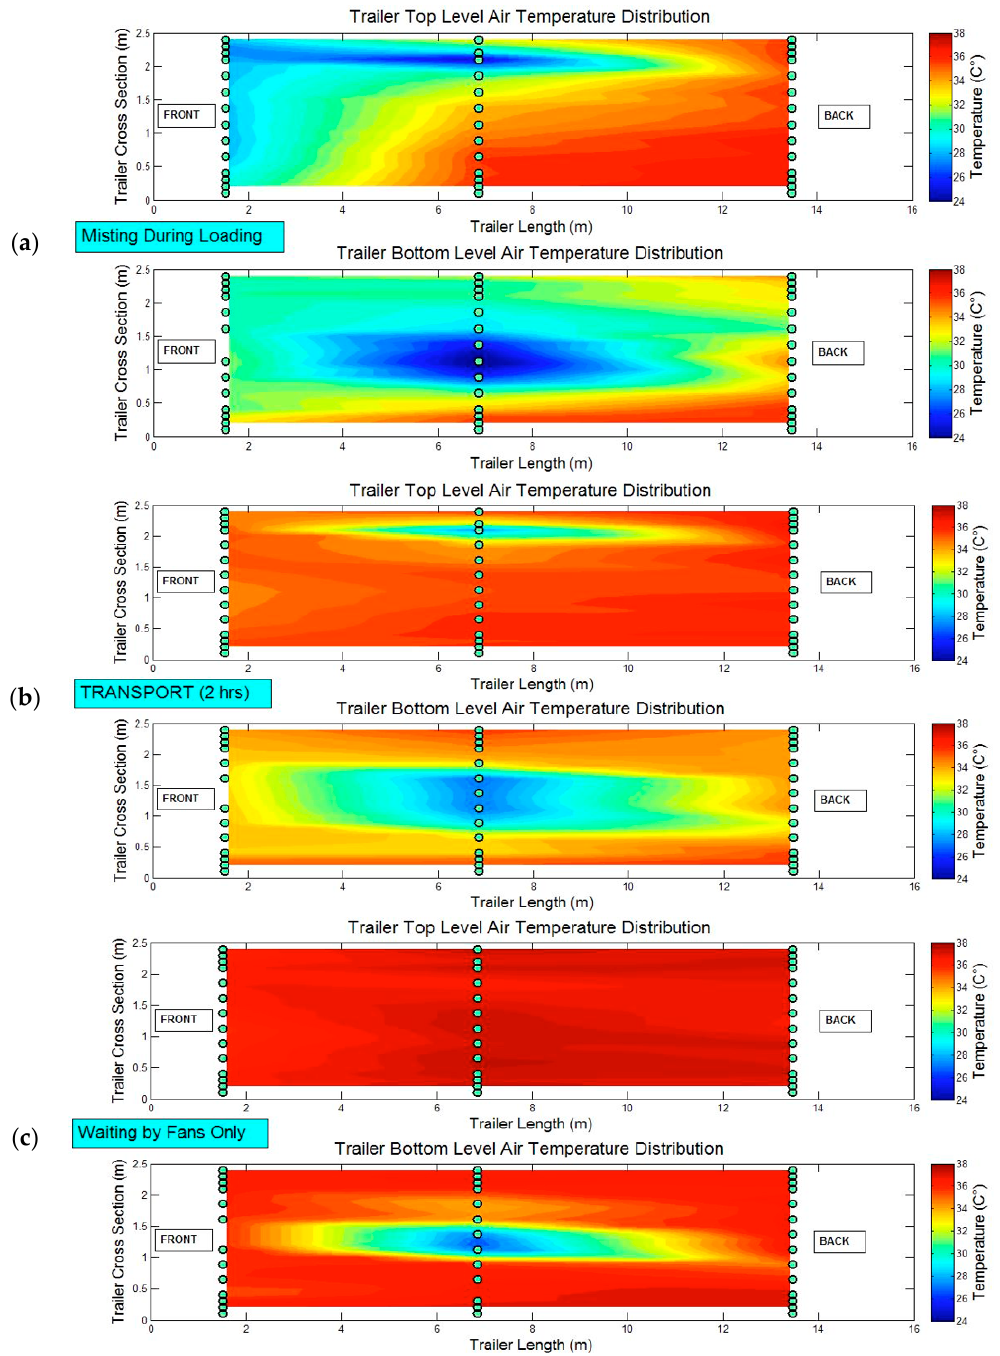
Figure 4. Trailer interior temperature distribution for three events during a hot summer monitoring trip (T out > 32 °C). Lighter color areas represent cooler temperatures inside the trailer, and potentially the cooling effects of the misting lasted into the transport segment. The three events were: ( a ) trailer was stationary, and misting was applied inside onto the pigs and bedding; ( b ) trailer was moving; and ( c ) stationary trailer loaded with pigs at abattoir waiting besides external fans with misting previously applied. The green circles indicate position of air temperature sensors at the pig level.